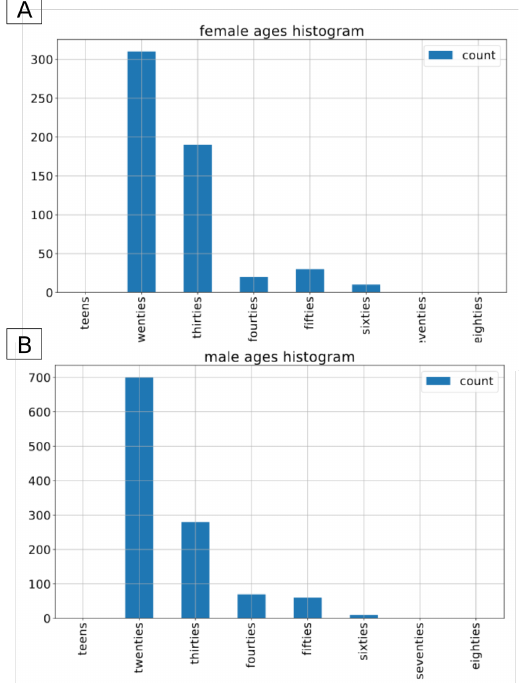
Figure 6. TIMIT: age distribution by gender in the test. ( A ) female speakers, ( B ) male speakers.